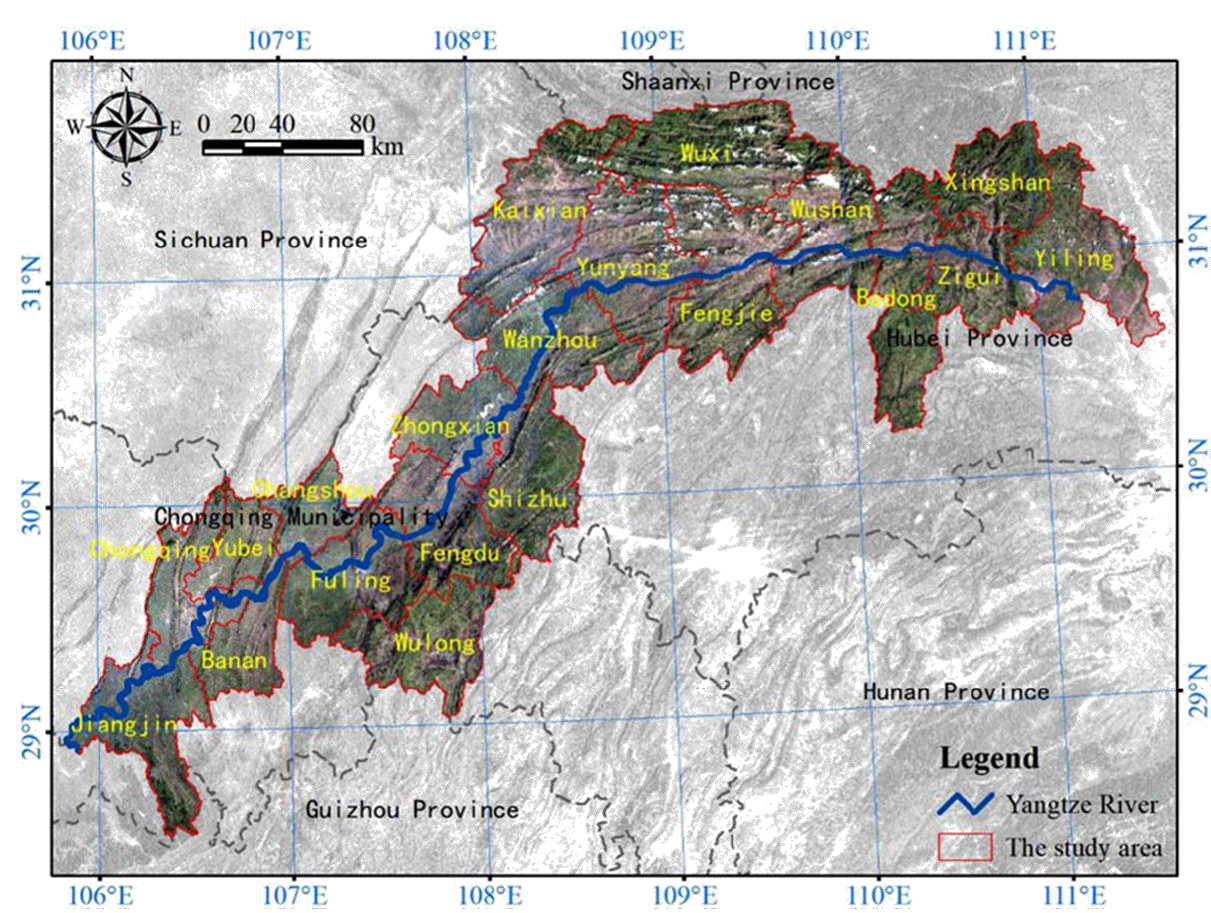
Figure 1. Location of the Three Gorges Reservoir area in China.